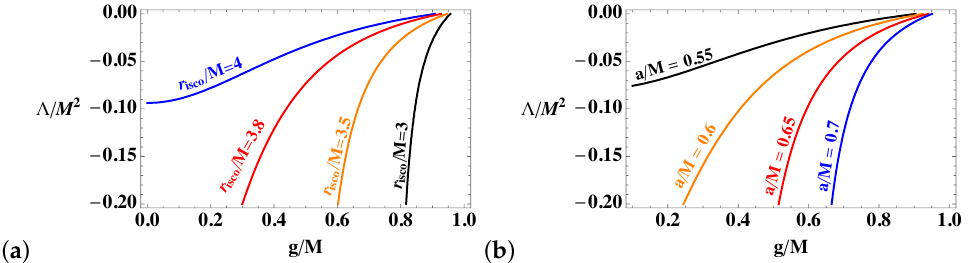
Figure 7. The degeneracy plot between Λ and g for the fixed selected values of ( a ) the ISCO location r ISCO and ( b ) the spin parameter a